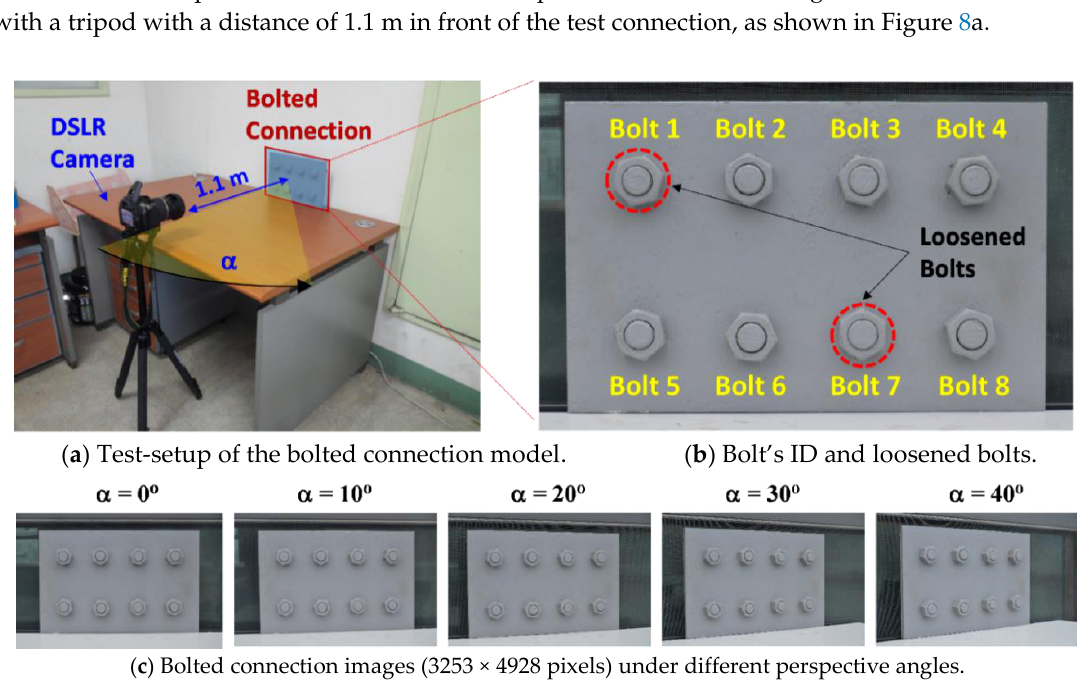
Figure 8. Experimental setup of lab-scaled bolted connection model. Table 1. Bolt-loosening test of lab-scaled bolted connection model.